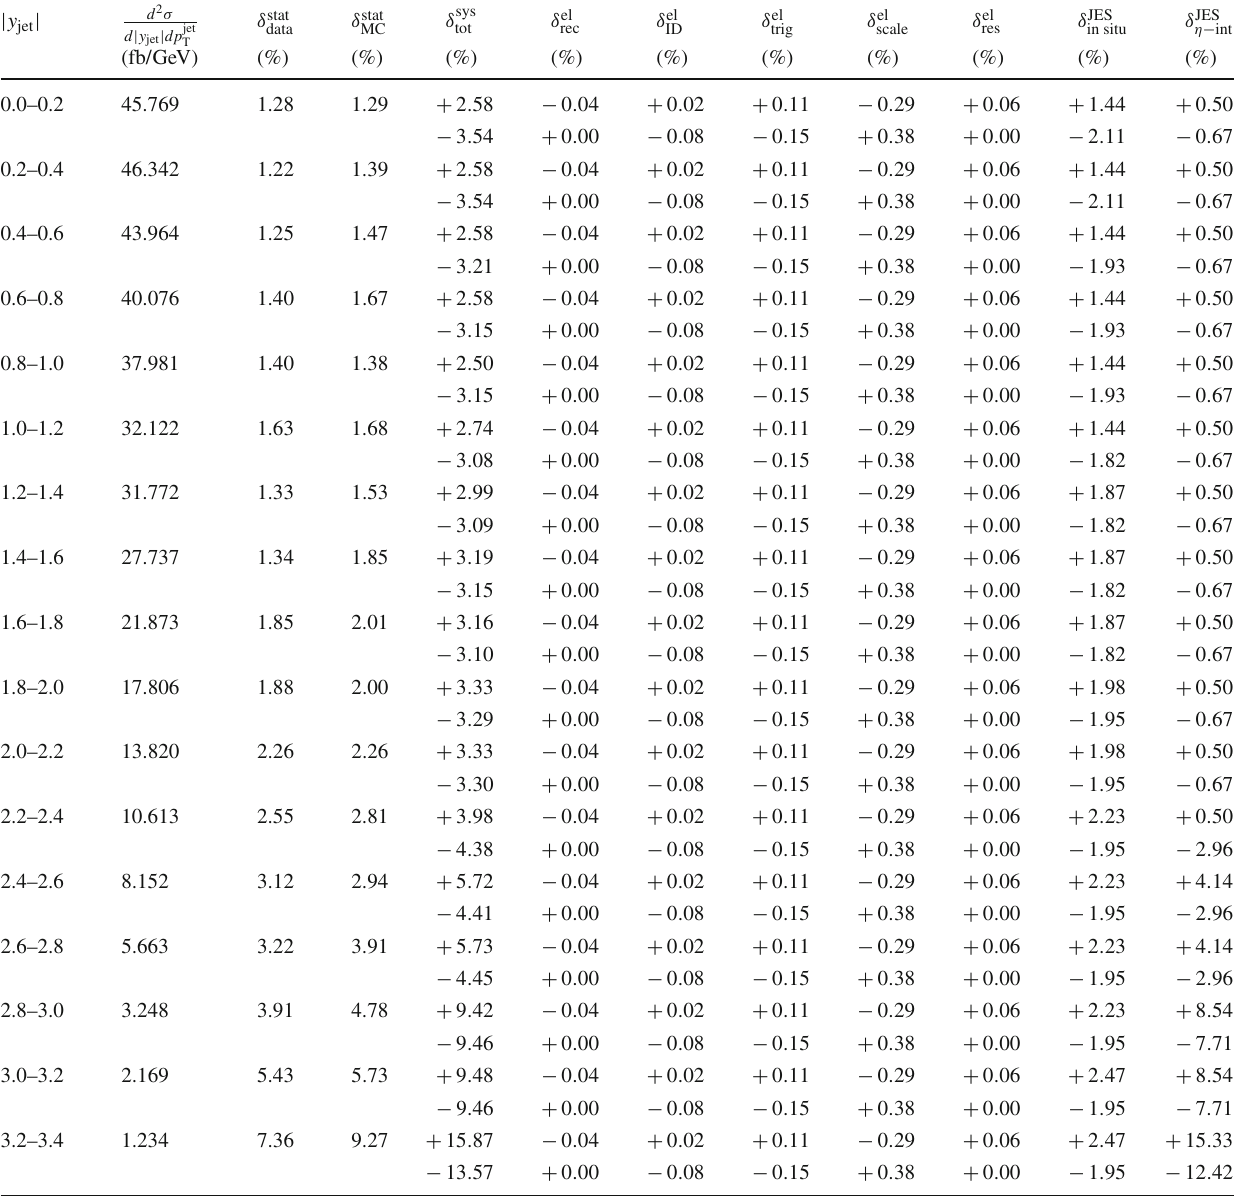
Table 5 The measured double-differential Z + jets production cross- sections as a function of | y jet | in the 100GeV < p jet δ stat and δ stat are the statistical uncertainties in data and MC simulation, data MC respectively. δ sys tot is the total systematic uncertainty and includes the fol- lowing components: uncertainties due to electron reconstruction ( δ el rec